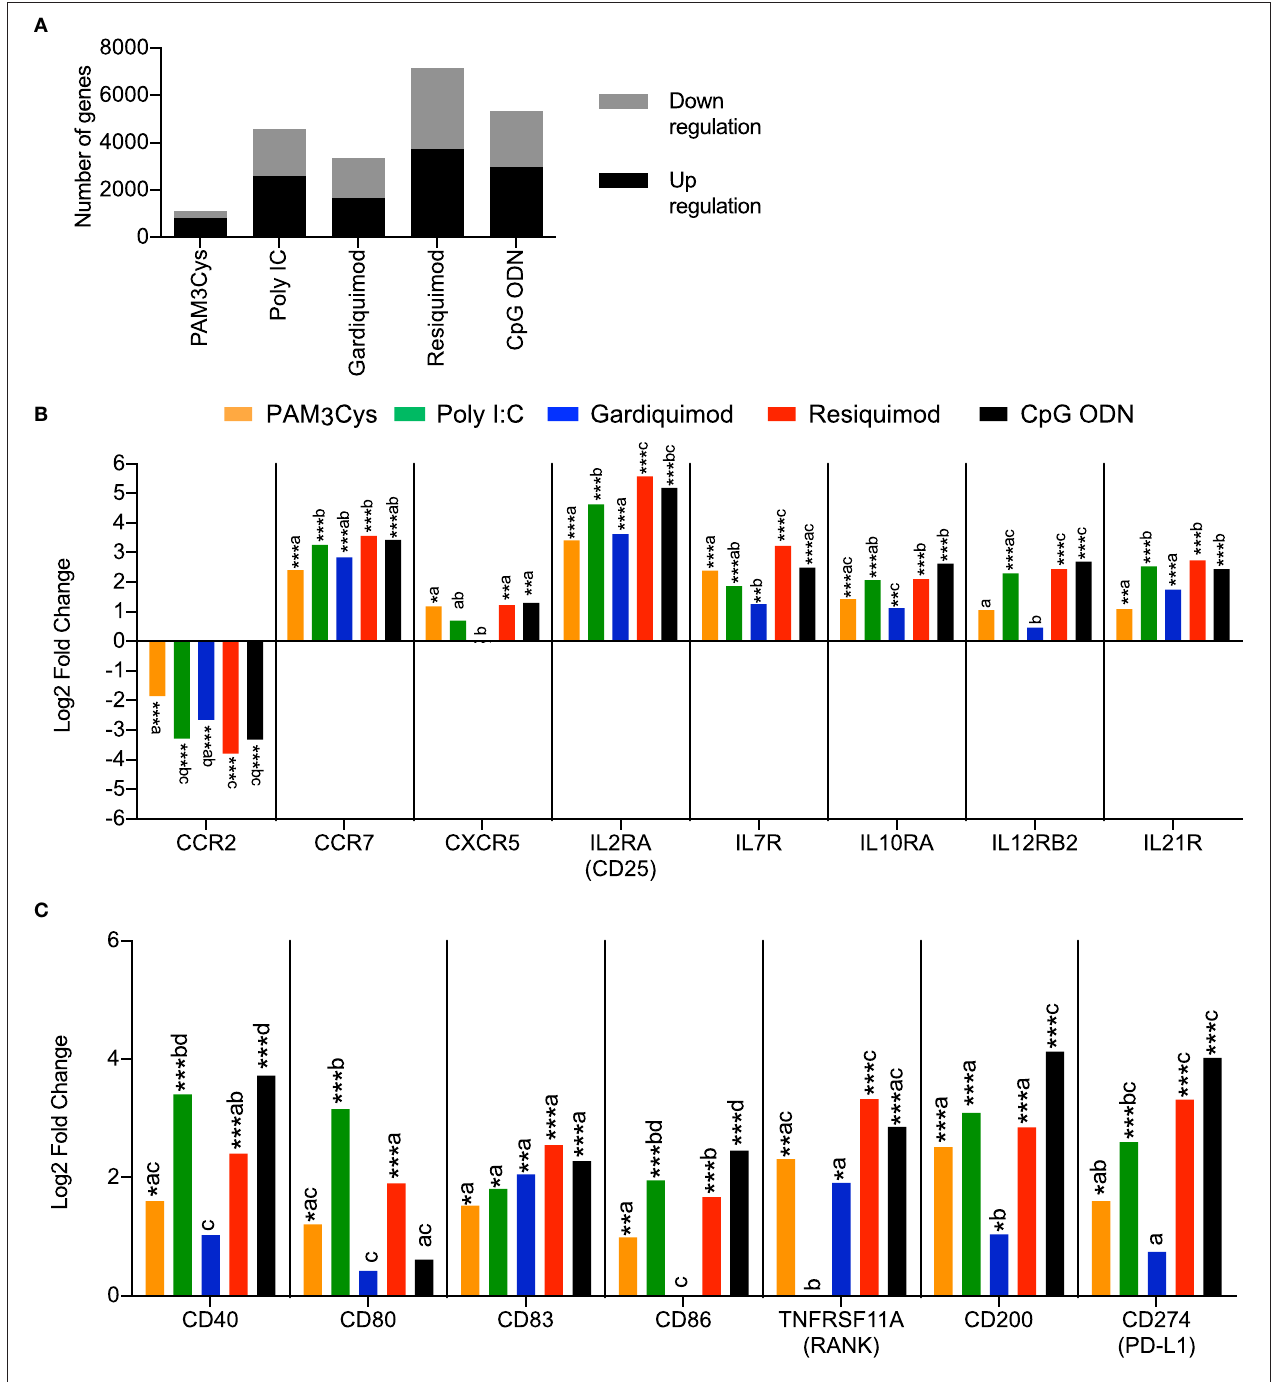
FIGURE 2 | Transcription profiles of porcine blood pDC stimulated with TLR ligands. pDC from three different animals were sorted by FACS and stimulated with 10 µ g/ml of PAM3Cys, 10 µ g/ml poly I:C, 5 µ g/ml gardiquimod, 5 µ g/ml resiquimod, 5 µ g/ml CpG ODN D32, or were left unstimulated as control. (A) Number of significantly regulated genes (Padj < 0.05) when comparing TLR ligand-stimulated pDC to control pDC. (B) Expression of selected chemokines and cytokines receptor genes as log2 fold change between TLR ligand-stimulated pDC and control pDC. (C) Expression of selected costimulatory molecule genes as log2 fold change between TLR ligand-stimulated pDC and control pDC. DESeq2 analysis * padj < 0.05, ** padj < 0.001, *** padj < 0.0001. For each gene, different letters indicate statistical significance between two TLR-ligand stimulation groups as calculated by DESeq2 analysis.